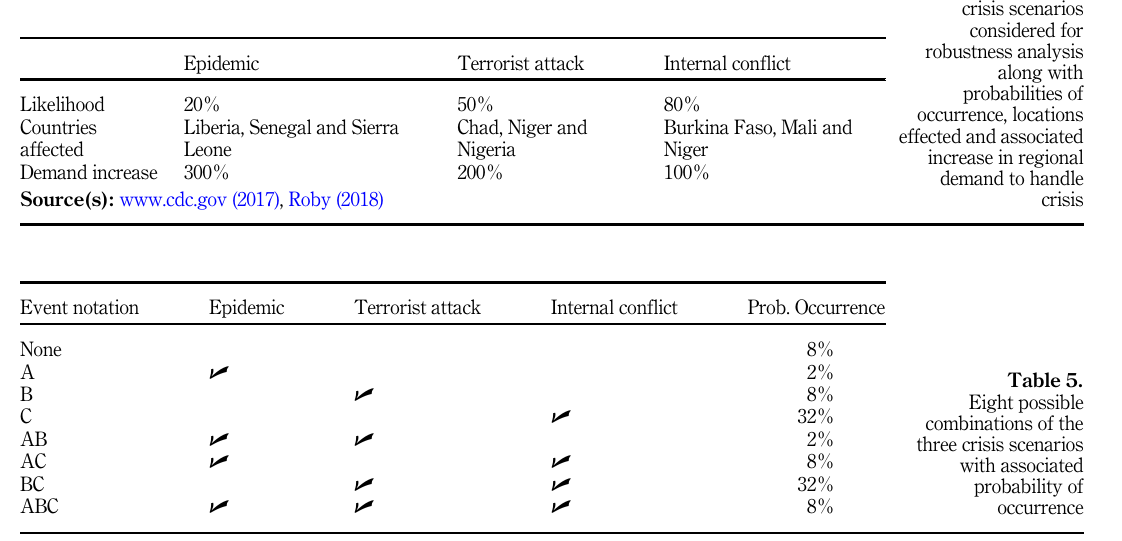
Table 4. Threenon-independent